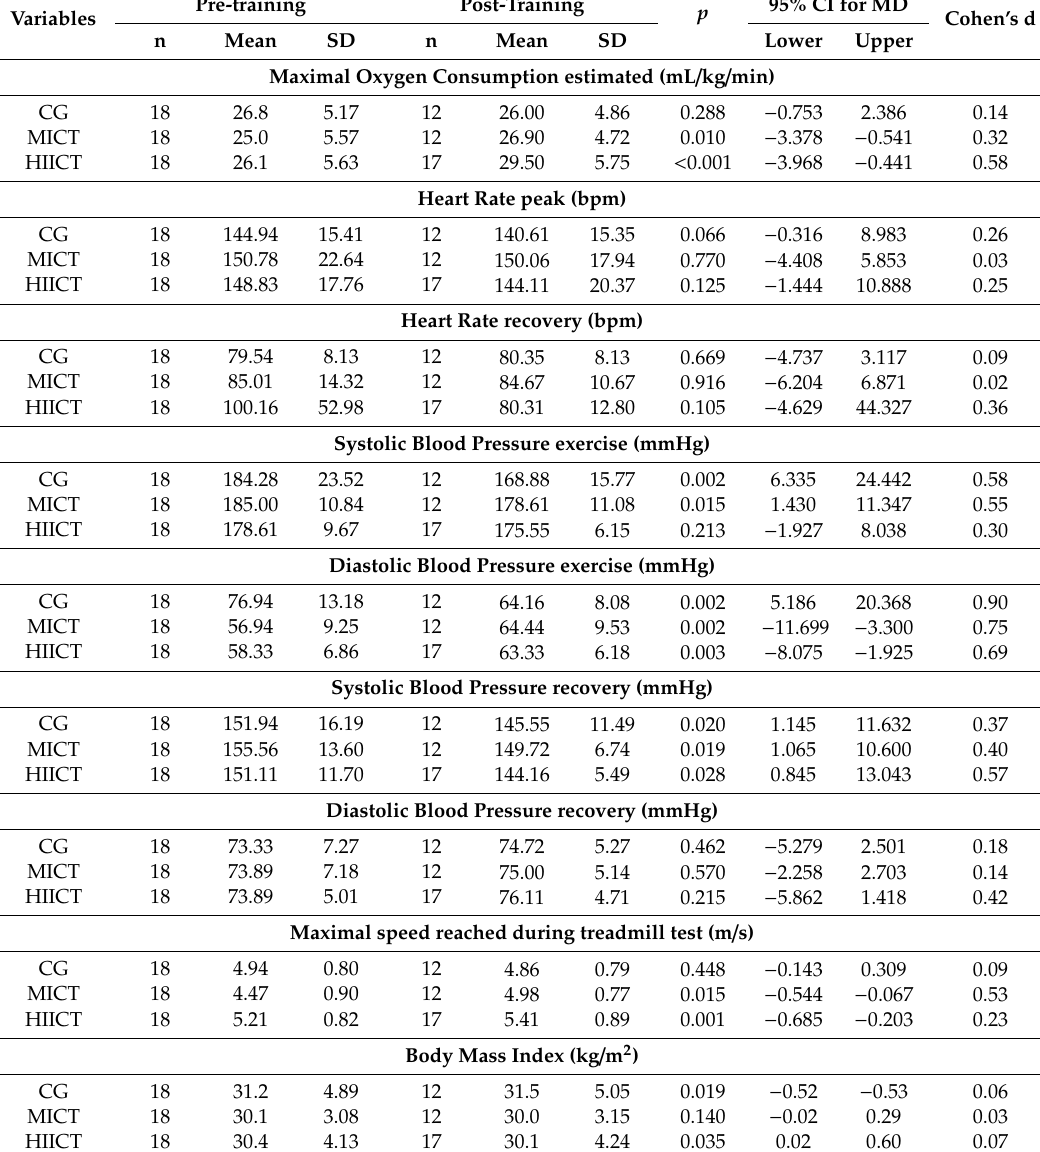
Table 3. Intra-group di ff erences on HIICT, MICT, and